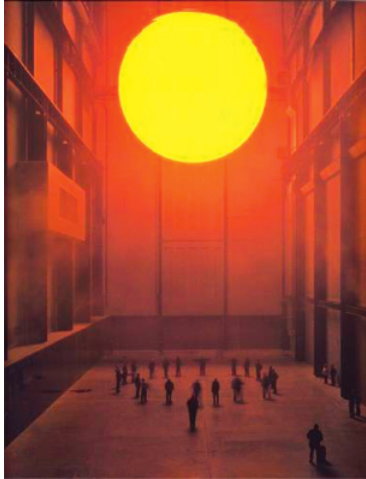
Fig. 1. Olafur Eliasson. The Weather Project . Tate Modern, London, 2009 (Bjone 2009: 114) Note: While white light functions as an information resource that allows us to see all the colours, the monochromatic yellow lighting in The Weather Project permits us to see only illuminated orange surfaces or not illuminated black